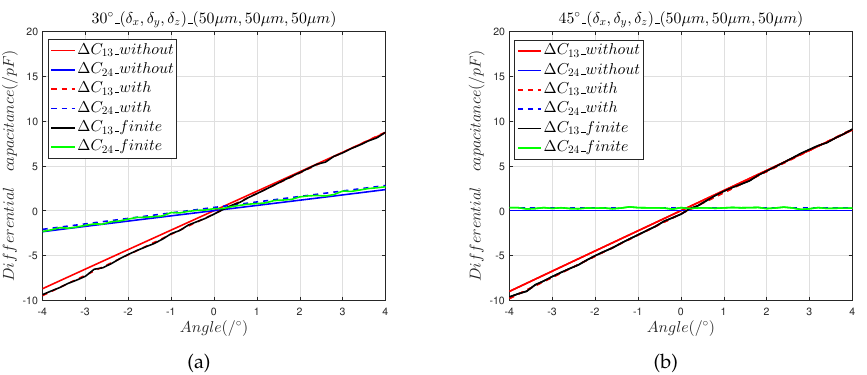
Figure 8. The 5 µ m composite installation error analysis: ( a ) differential capacitance in the 30° direction; ( b ) differential capacitance in the 45° direction.